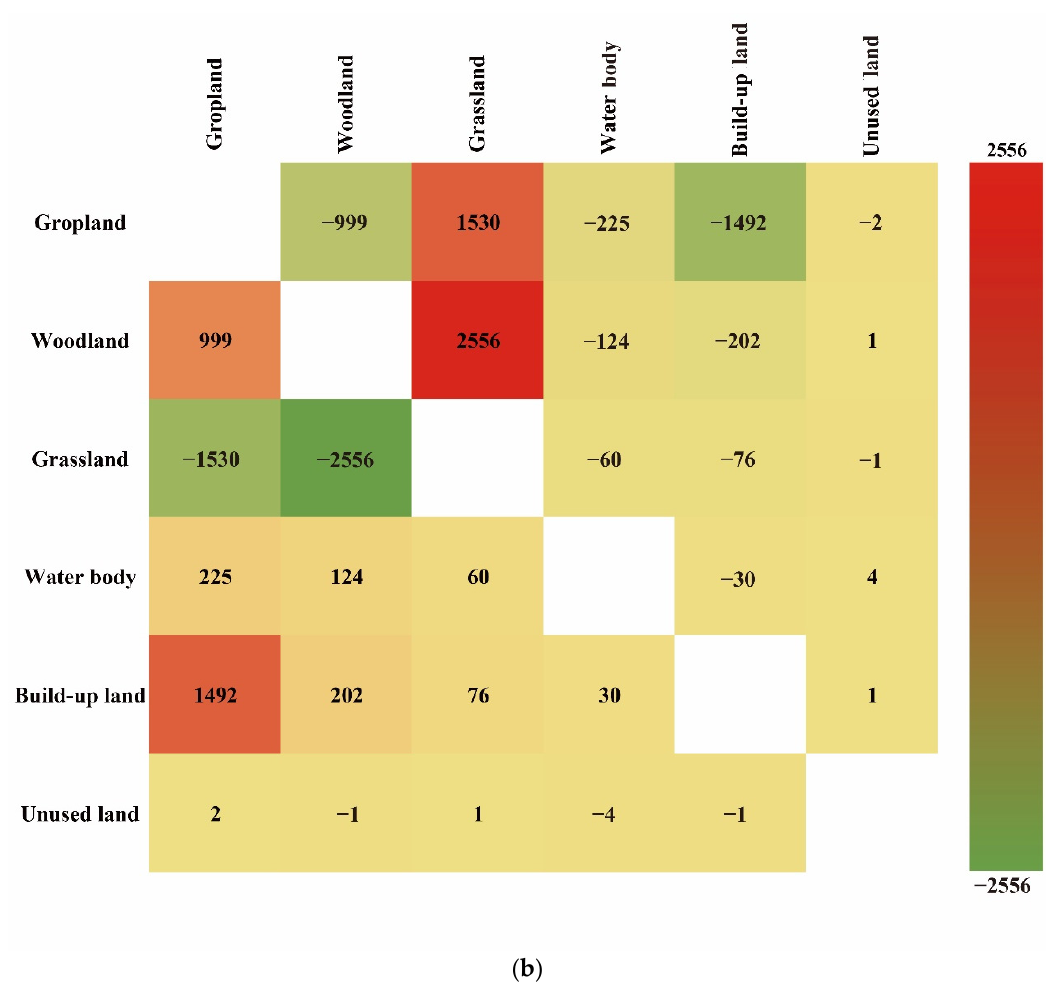
Figure 7. During 2000–2020, each type receives theoretical contributions from other types. ( a ) Natural scenario (unit: km 2 ) and ( b ) Policy scenario (unit: km 2 ).